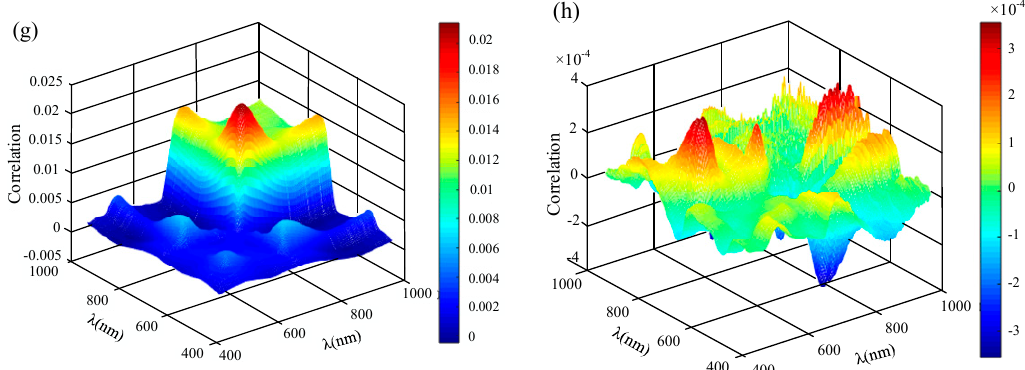
Figure 5. Two-dimensional correlation spectra of leaves. (a) Synchronous spectrum of Leymus chinensis , (b) asynchronous spectrum of Leymus chinensis , (c) synchronous spectrum of Cleistogenes squarrosa , (d) asynchronous spectrum of Cleistogenes squarrosa , (e) synchronous spectrum of Potentilla acaulis , (f) asynchronous spectrum of Potentilla acaulis , (g) synchronous spectrum of Scutellaria scordifolia , (h) asynchronous spectrum of Scutellaria scordifolia .